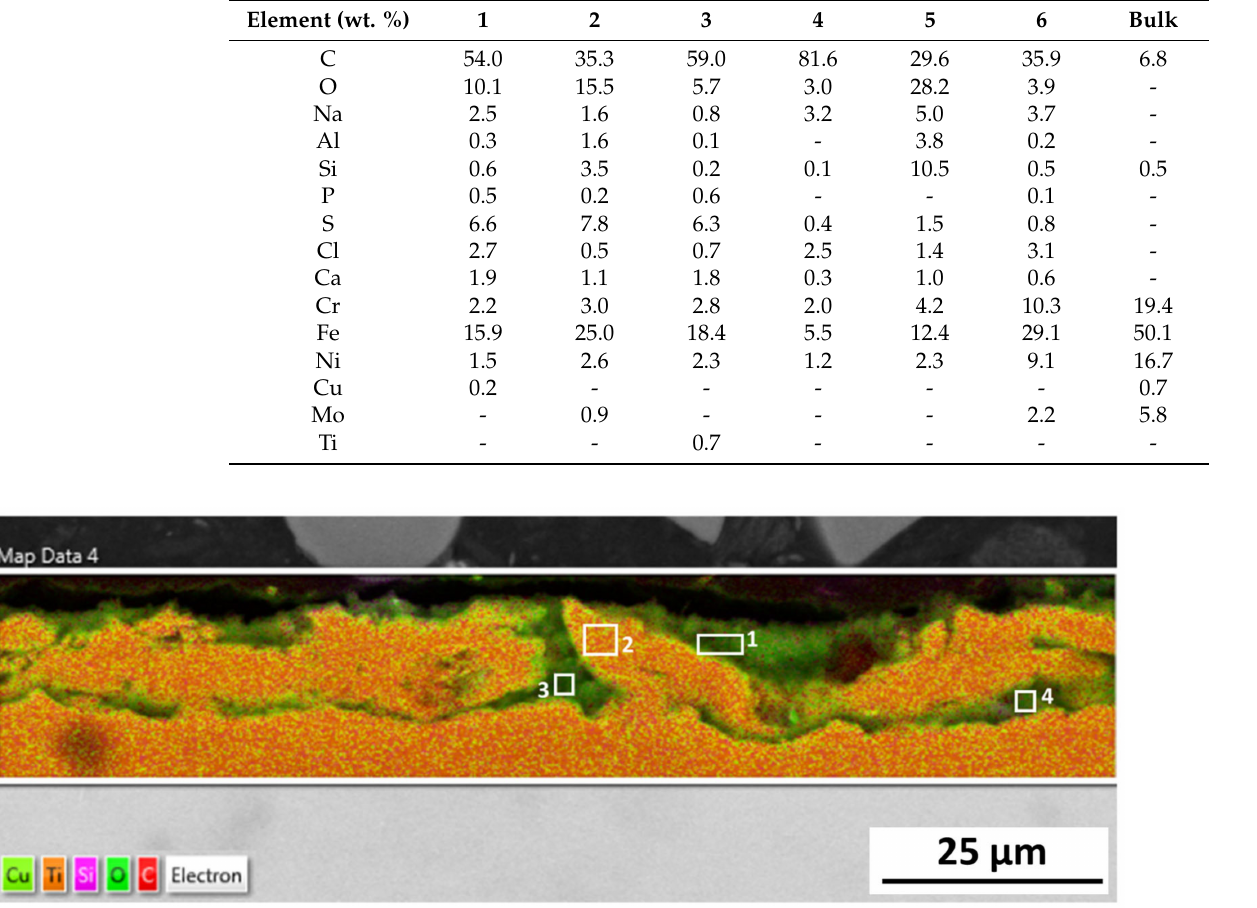
Figure 18. Ti gr. 2 after exposure in Reykjanes where around 10 µ m of material is loosely attached to the base material. Four locations analysed with EDX are shown. Locations 1,3 and 4 show high amounts of Cu deposits while location 2 is nearly pure Ti. The profile shows an indication of erosion. The colour map shows the relative composition of Cu, Ti, Si, O and C in the